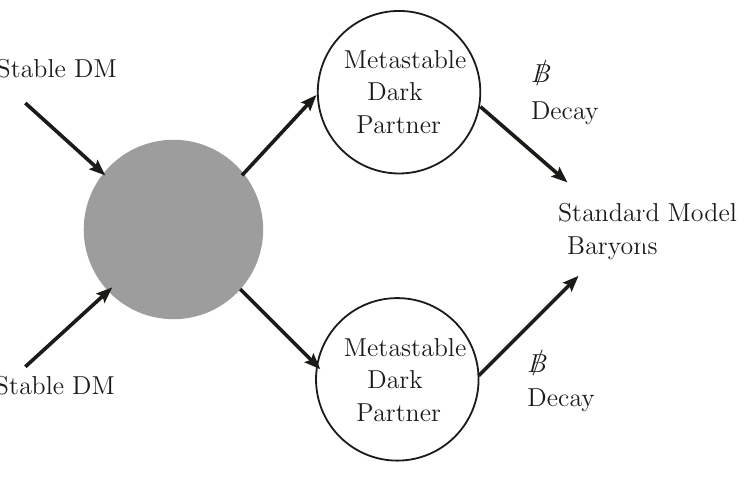
Figure 1 . Schematic diagram outlining the key stages in the dark freeze-out cogenesis